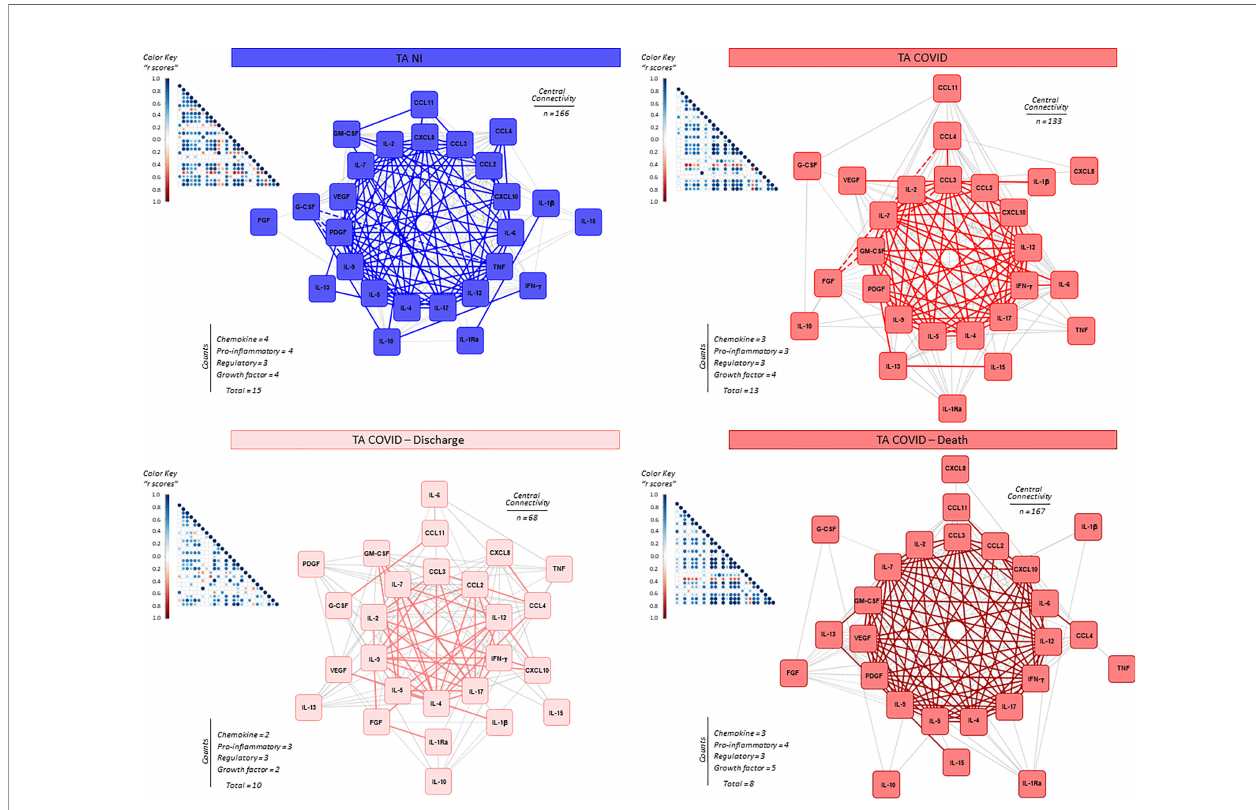
FIGURE 7 | Integrative correlation matrices and networks analysis of airway soluble immune mediators in tracheal aspirates from critically ill COVID-19 patients at ICU admission. Comprehensive correlation matrices were assembled based on the Pearson and Spearman “ r ” scores between chemokines, pro-in fl ammatory cytokines, regulatory cytokines, and growth factors measured in tracheal aspirates from critically ill COVID-19 patients – “ COVID ” ( ■ , n = 103) at ICU admission (D0=baseline), further classi fi ed according to disease outcome: referred as “ Discharge ” ( ■ , n = 37) or “ Death ” ( ■ , n = 66) and non-infected patients – “ NI ” ( ■ , n = 18). The soluble mediators were measured by high-throughput microbeads array as described in Material and Methods section. Panoramic correlation matrices are shown as triangle templates with each square intersection representing the “ r ” correlation score between pairs of attributes. The “ r ” scores of signi fi cant correlations (p < 0.05) are represented by circles of proportional sizes, scaled from − 1 to +1 with gradient for negative (red dots) and positive (bule dots) according to the color key provided in the fi gure. The white squares represent non-signi fi cant correlations. Networks were built using a layout based on eccentricity, considering all signi fi cant correlations. The nodes represent the chemokines (CXCL8, CCL11, CCL3, CCL4, CCL2, CXCL10), pro-in fl ammatory cytokines (IL-1 b , IL-6, TNF, IL-12, IFN- g , IL-15, IL-17), regulatory cytokines (IL-1Ra, IL-4, IL-5, IL-9, IL-10, IL-13) and growth factors (FGF-basic, PDGF, VEGF, G-CSF, GM-CSF, IL-7 and IL-2). Connecting edges illustrate weak/moderate ( “ r ” scores between |0.1 to 0.67|, thin gray lines) and strong correlations ( “ r ” scores ≥ |0.67|, thick colored lines) between pairs of attributes. Negative correlations are underscored by dashed lines. Attributes without strong correlations are distributed in the network periphery. Serum soluble mediators presenting at least 5 strong correlations are assembled in the center with the number of each category and connections between them (central connectivity) are provided in the